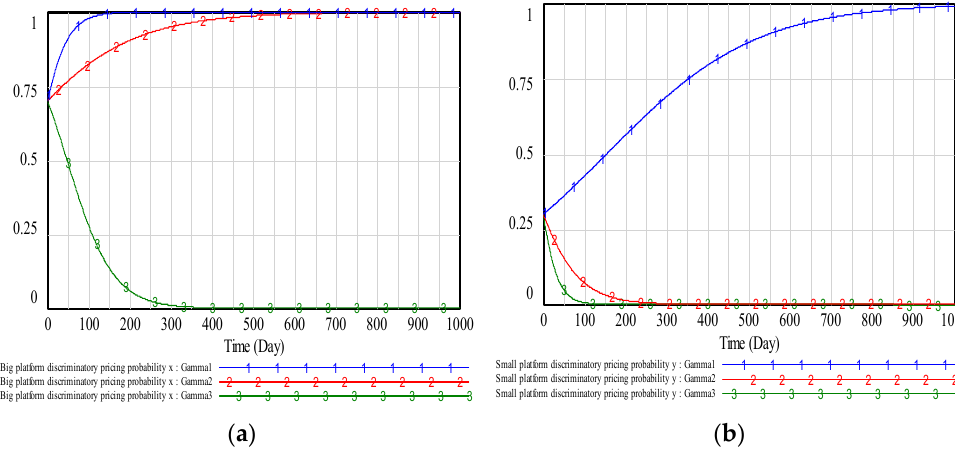
Figure 6. System simulation results of the sensitivity analysis to γ . ( a ) The impact of γ on the big platform discriminatory pricing probability x . ( b ) The impact of γ on the small platform discriminatory pricing probability y .